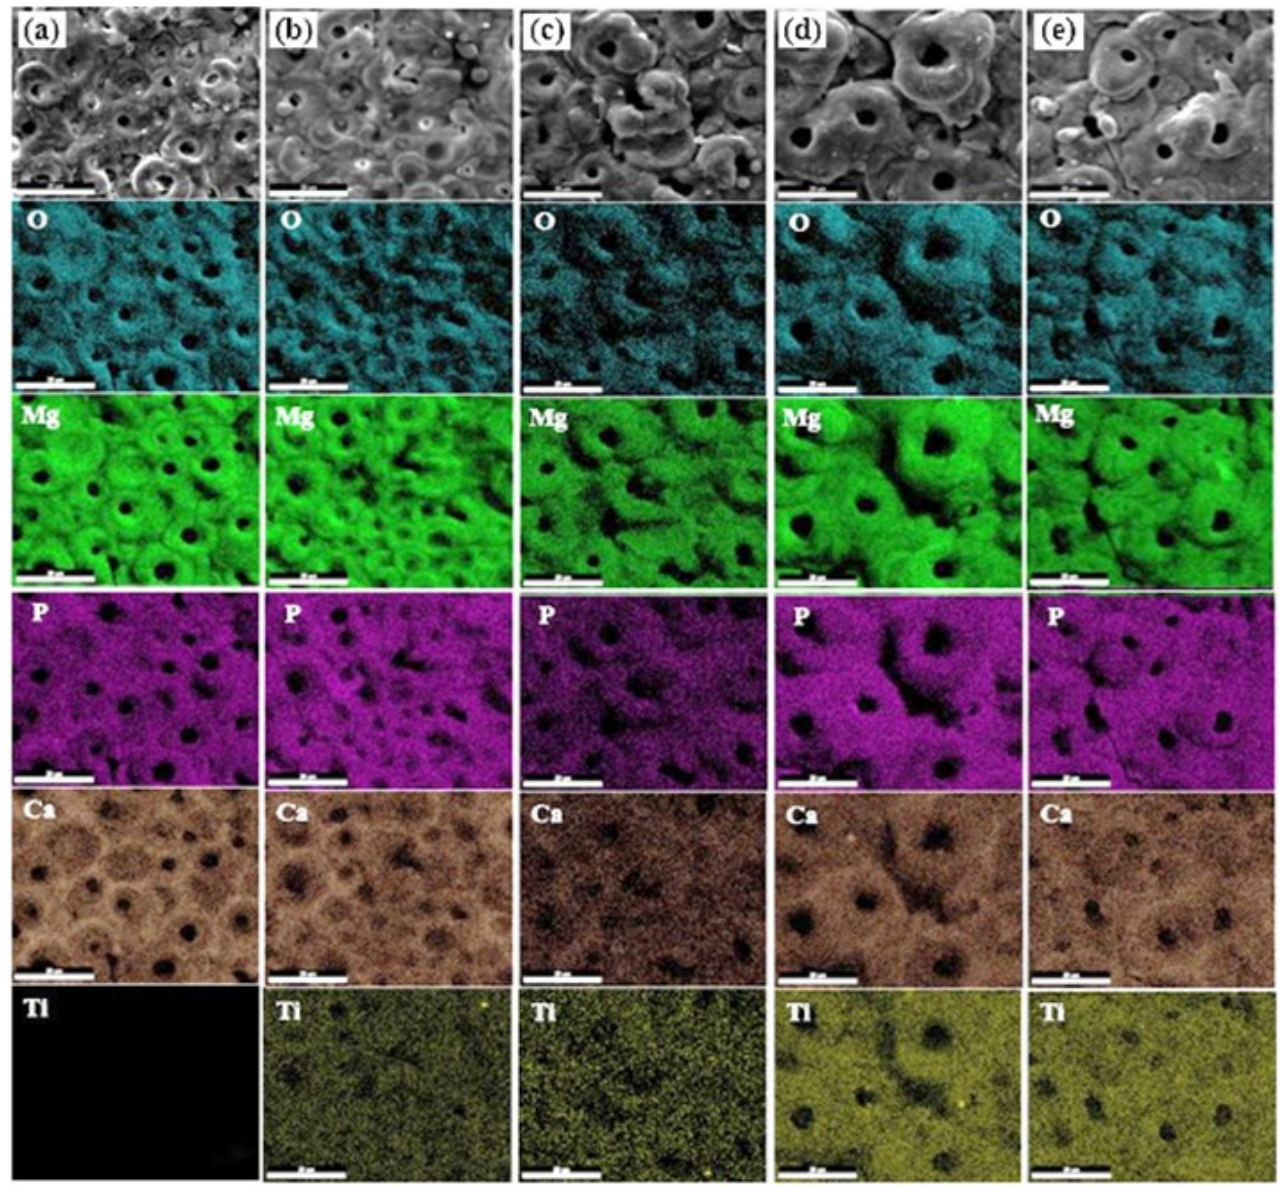
Figure 6. The surface EDS elemental mapping of PEO-coated specimens at various concentrations of TiO2: ( a ) 0, ( b ) 1, ( c ) 2, ( d ) 3 and ( e ) 4 g/L. TiO 2 : ( a ) 0, ( b ) 1, ( c ) 2, ( d ) 3 and ( e ) 4